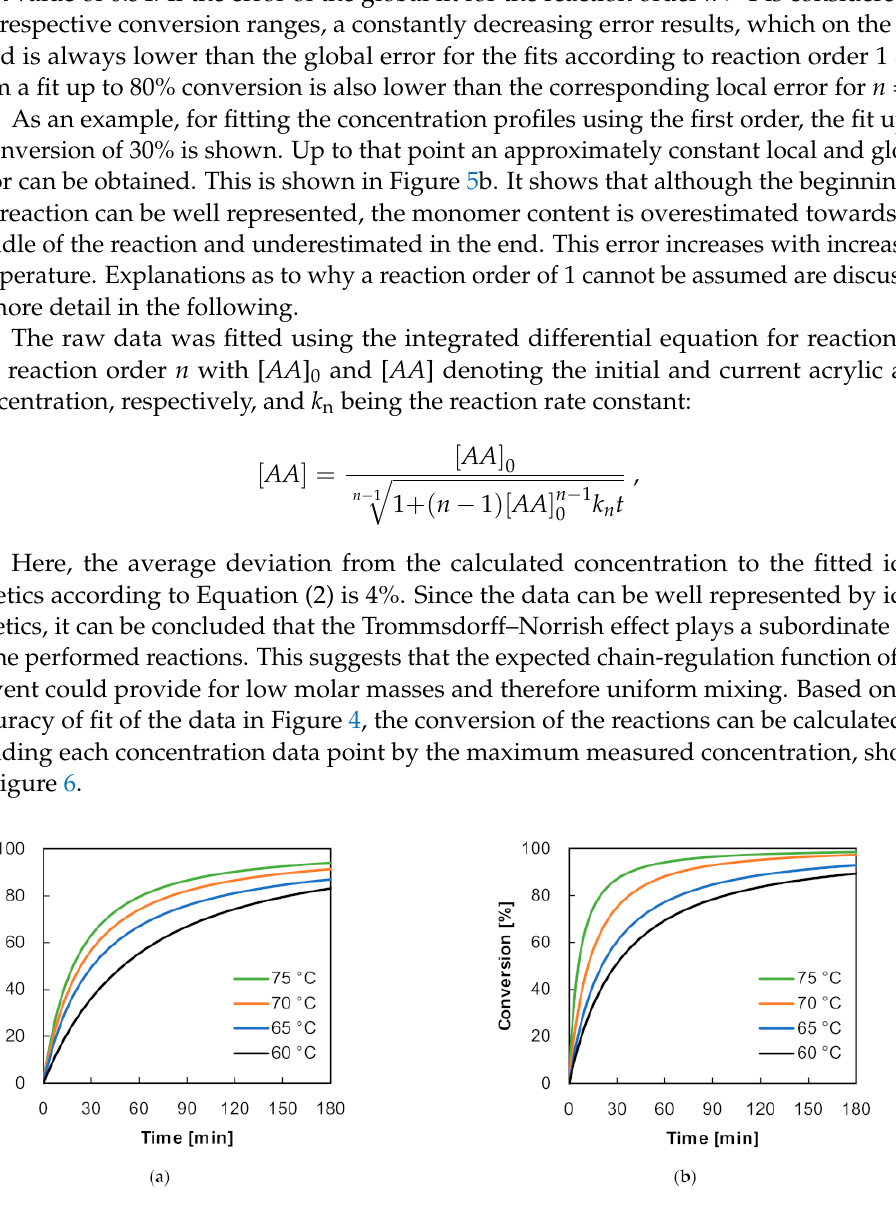
Figure 6. Conversion of acrylic acid polymerisations in isopropyl alcohol (150 g/L) at different temperatures determined by Raman spectroscopy: 0.5 mol% AIBN ( a ), and 1.0 mol% AIBN ( b